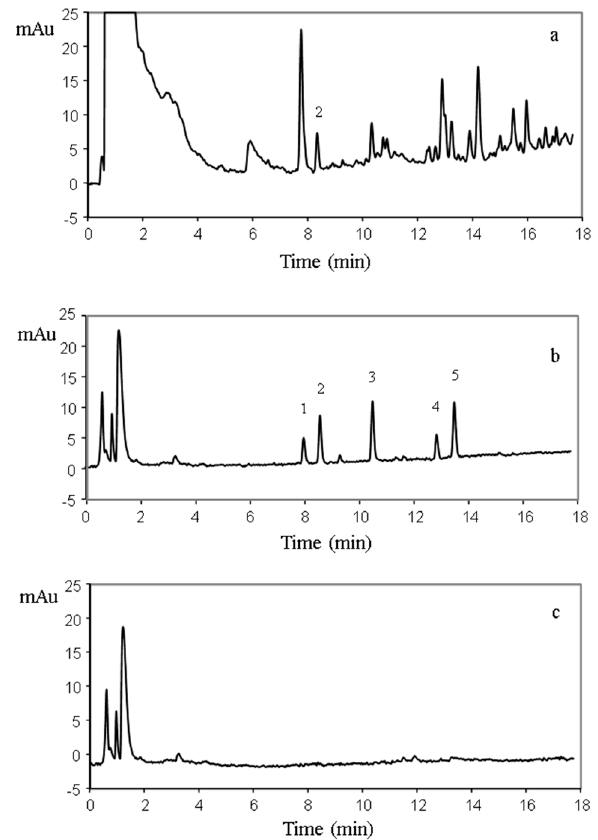
Figure 3. Comparison of chromatograms obtained in the analysis of soil samples from Murcia: ( a ) Spiked crude soil sample extract (10 ng g − 1 ); ( b ) Spiked soil sample extract (10 ng g − 1 ) after performing HFM-protected-MI-MSPE; ( c ) non-spiked soil sample extract after performing HFM-protected-MI-MSPE. Peak assignment: 1. SIM; 2. CYA; 3. ATZ; 4. PPZ; 5. TER.